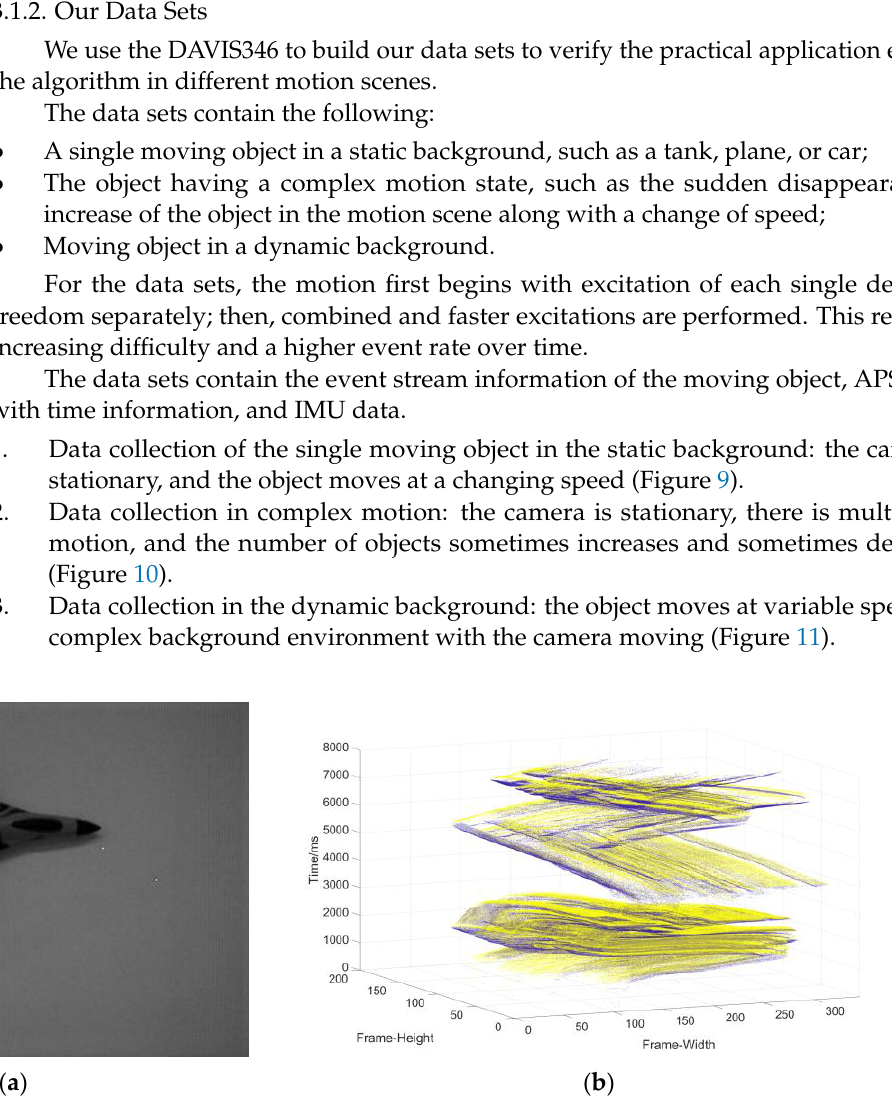
Figure 9. ( a ) The object used to generate the event stream; ( b ) three-dimensional spatiotemporal event stream generated by the object in ( a ).